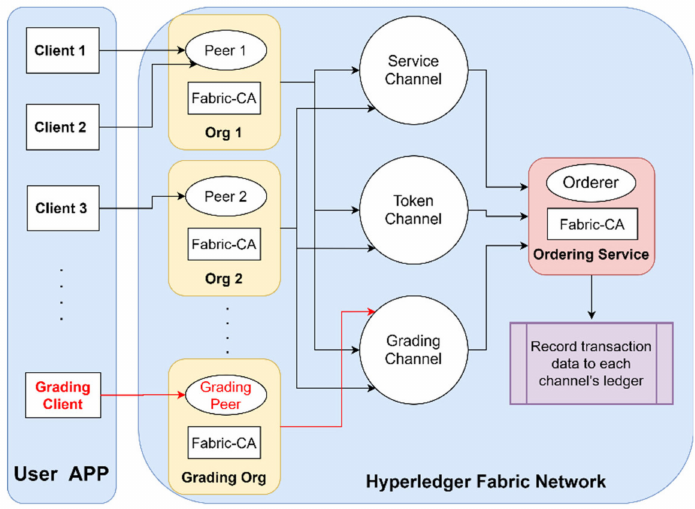
Figure 2. Architecture of our Fabric-based time bank